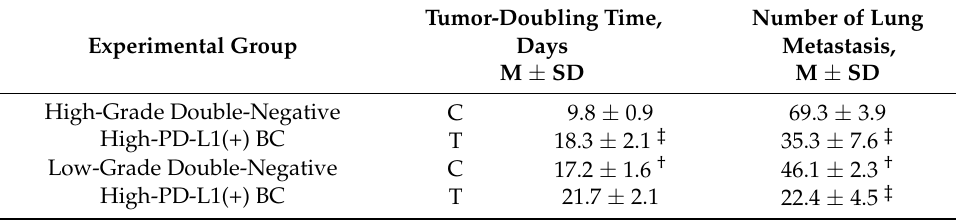
Table 1. PDX tumors’ response to experimental therapy with Durvalumab (n = 10 in each control and interventional group).